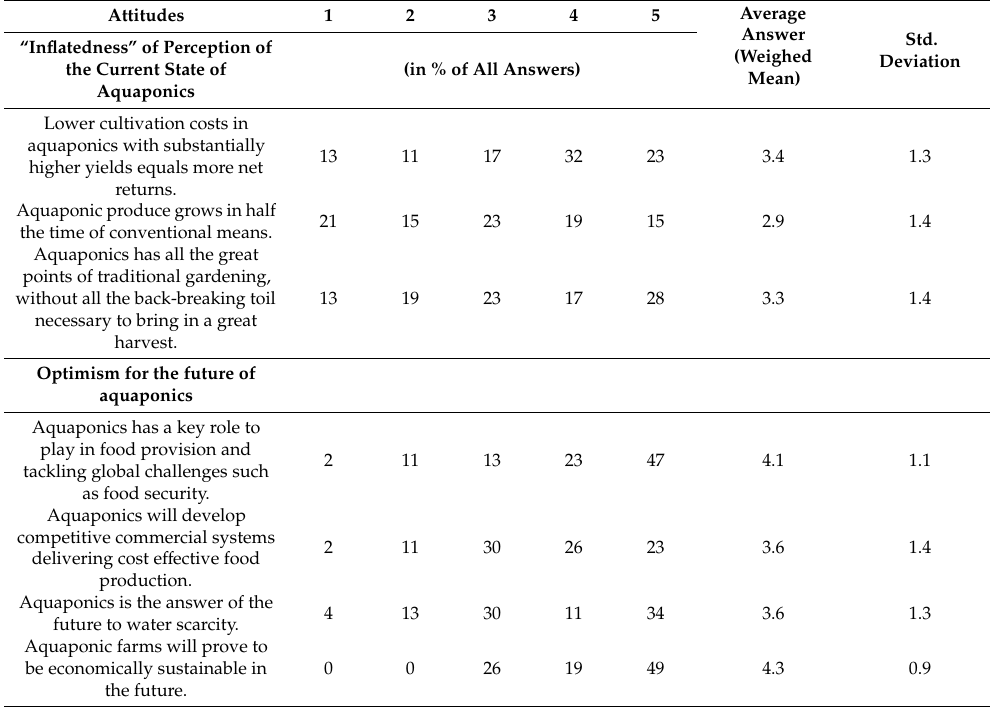
Answer Std. Deviation“Inflatedness” of Perception of (Weighed Mean)